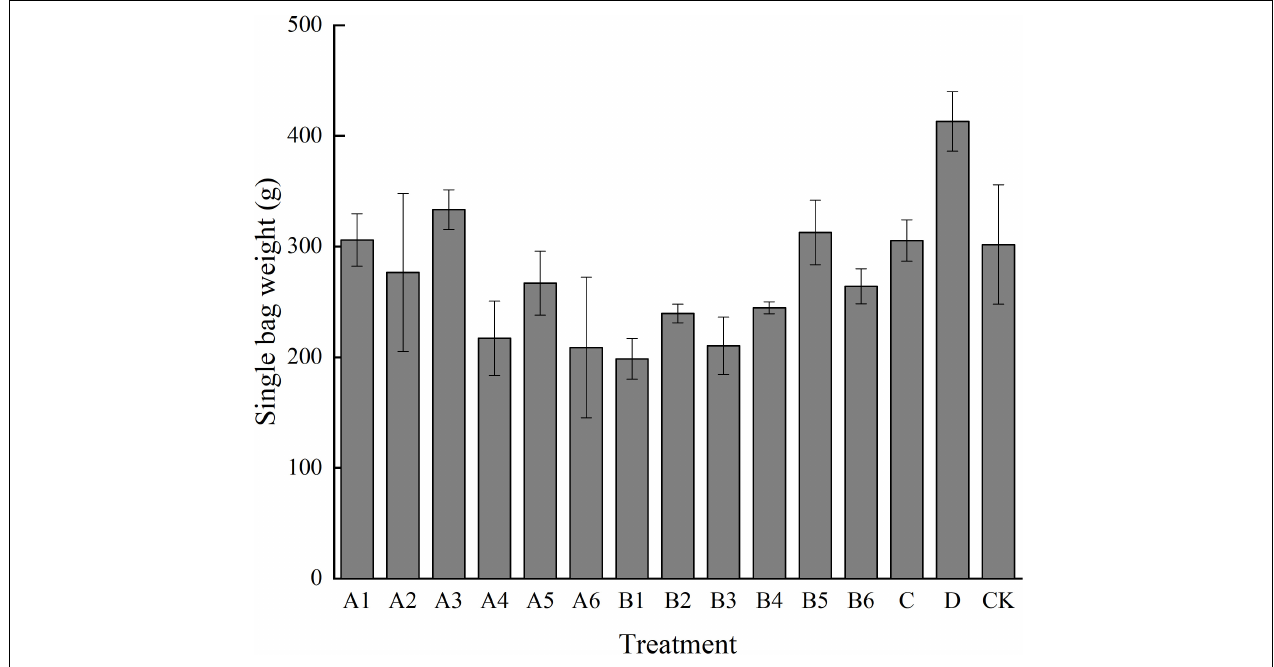
FIGURE 2 | Effects of different treatments on the weight of single bag. Different letters in the figure indicate significant differences ( P < 0.05).